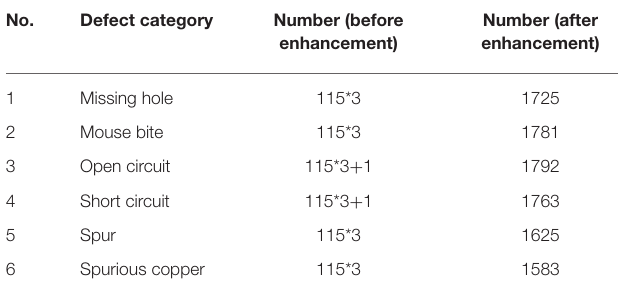
TABLE 1 | Comparison of the number of minor defects before and after data